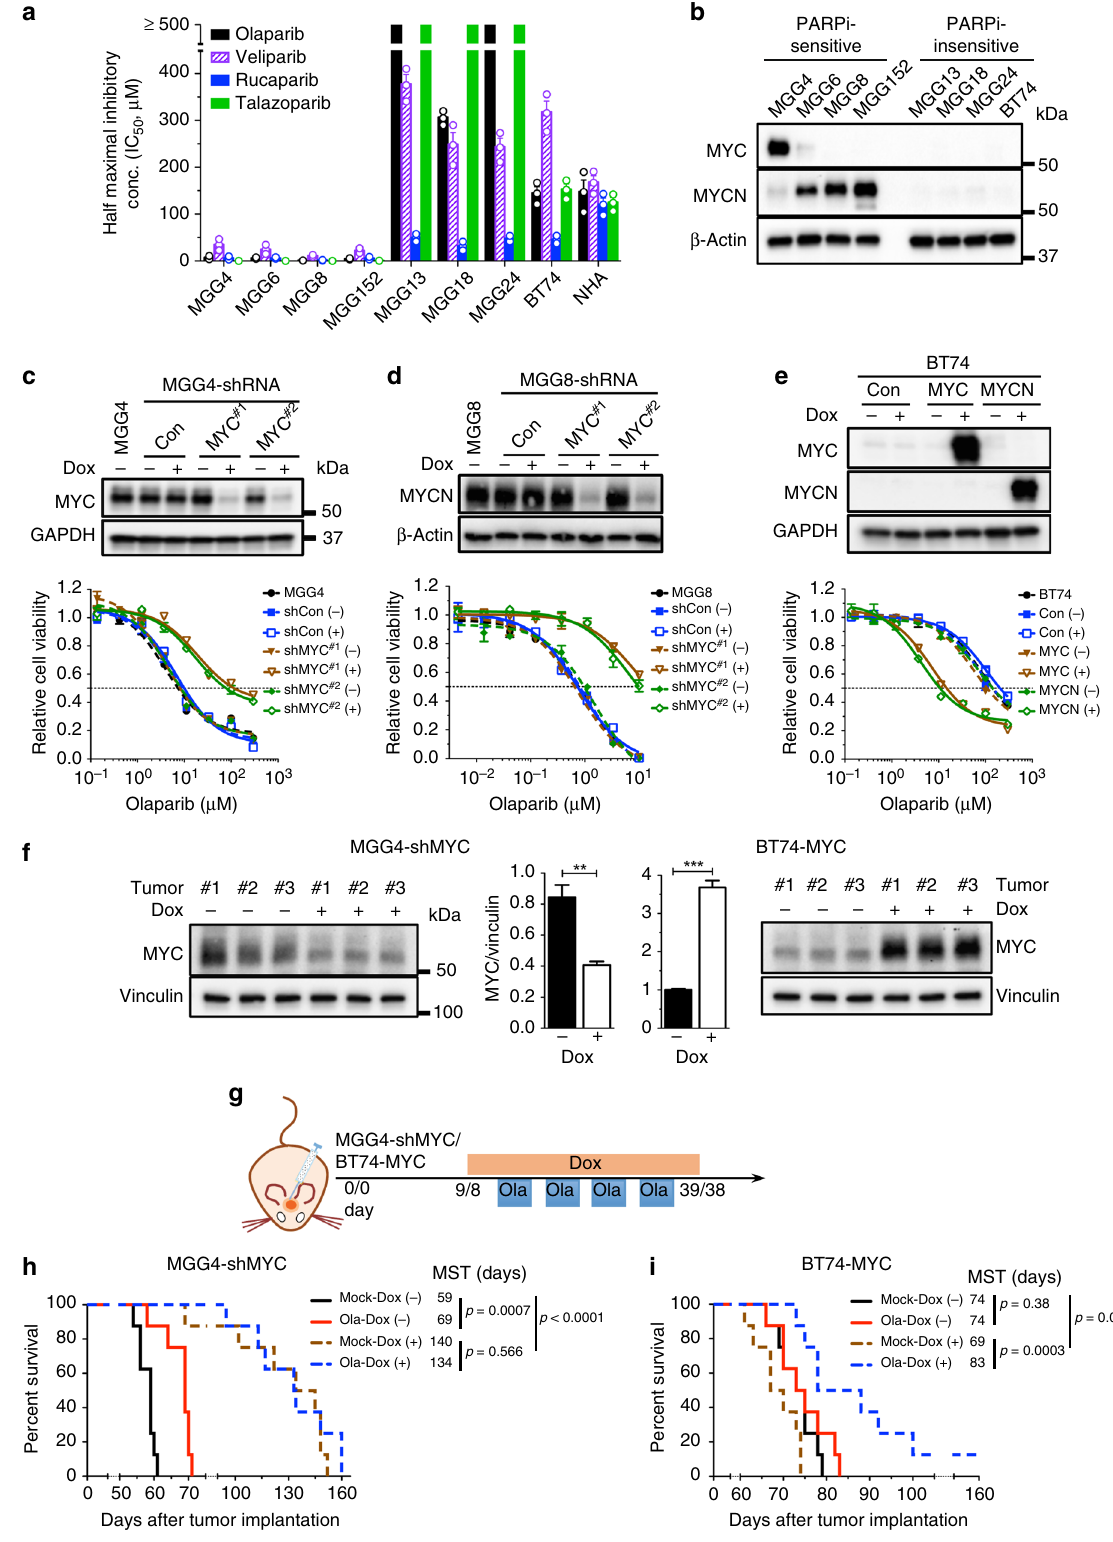
contribute to PARPi sensitivity. We then surveyed DDR genes and identi fi ed seven potentially interesting targets where MYC knockdown changed transcript levels over two-fold with sta- tistical signi fi cance ( p < 0.05, Chi-square test) and normalized values for shCon or shMYC over 1 (5: upregulated and 2: downregulated) (Fig. 2a, Supplementary Fig.